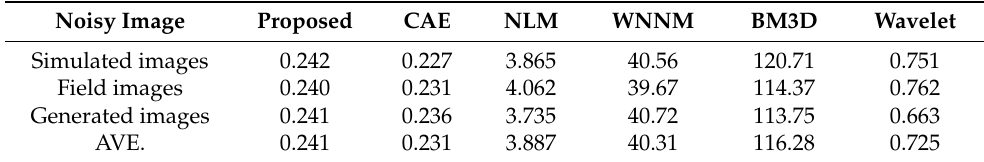
Table 3. Average time cost (s) for different denoising